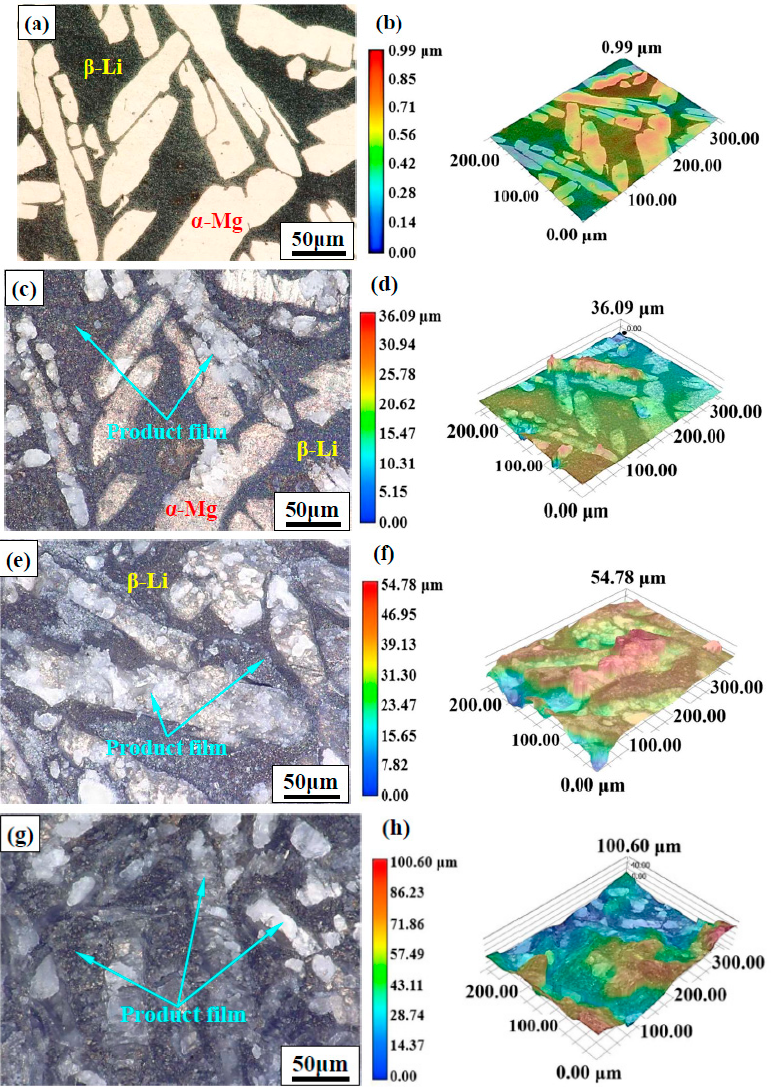
Figure 3. Surface and 3D morphologies of different samples after being hydrogen charged for: ( a ) 0 h, ( c ) 3 h, ( e ) 6 h and ( g ) 18 h. Images ( b ), ( d ), ( f ) and ( h ) are the corresponding 3D morphologies of images ( a ), ( c ), ( e ) and ( g ), respectively.